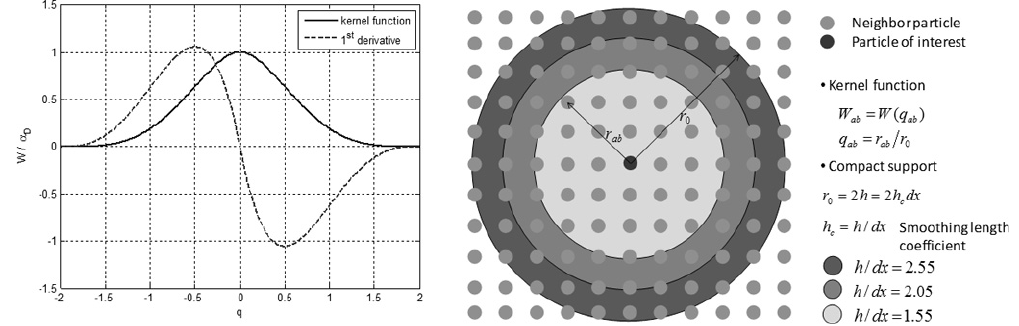
Fig. 1. The 5th order kernel function and its 1st derivative (left) and different compact support domains (right).